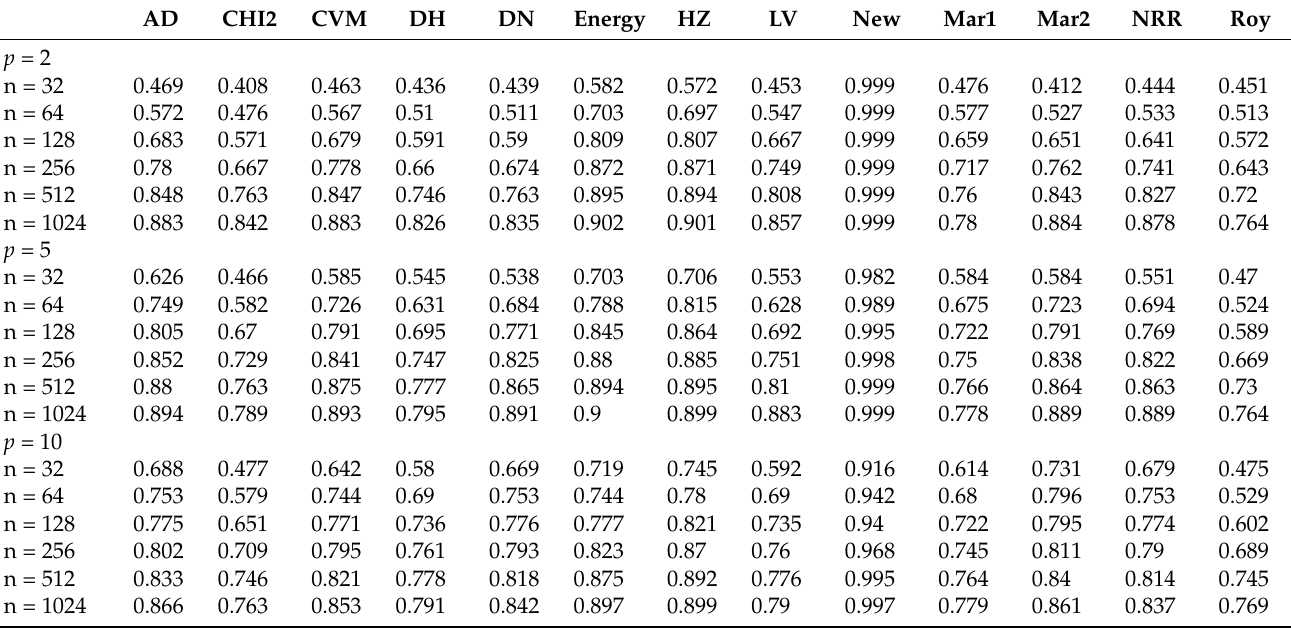
Table 4. An average empirical power for a group of mixed